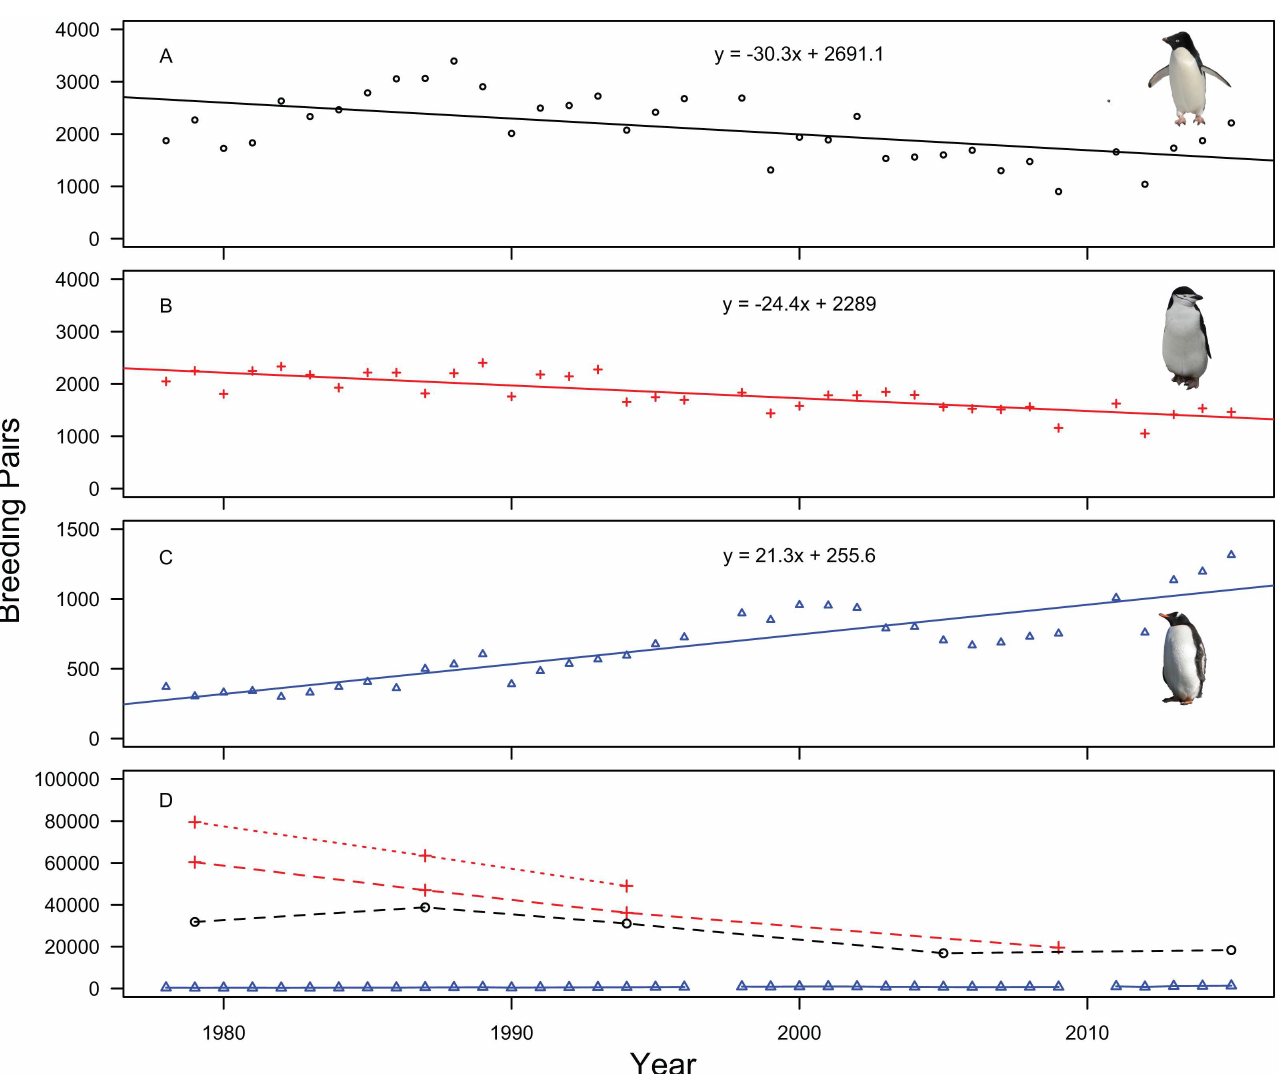
Fig 2. Trends in total number of penguin breeding pairs on Signy Island, 1978/79-2015/16. Legend:Panels A to C show annualcounts of Ade´lie (9 colonies),chinstrap (11 colonies)and gentoo (all 10 Signy Island colonies)penguinbreedingpairs, with accompanying linear regression values. Panel D shows all-islandcounts, with each species colour coded as shown in individualpanels A to C. Note: chinstrap (includingoffshore islands) = red crosses and dashed line, chinstrap (omitting offshore islands) = red crosses and dotted